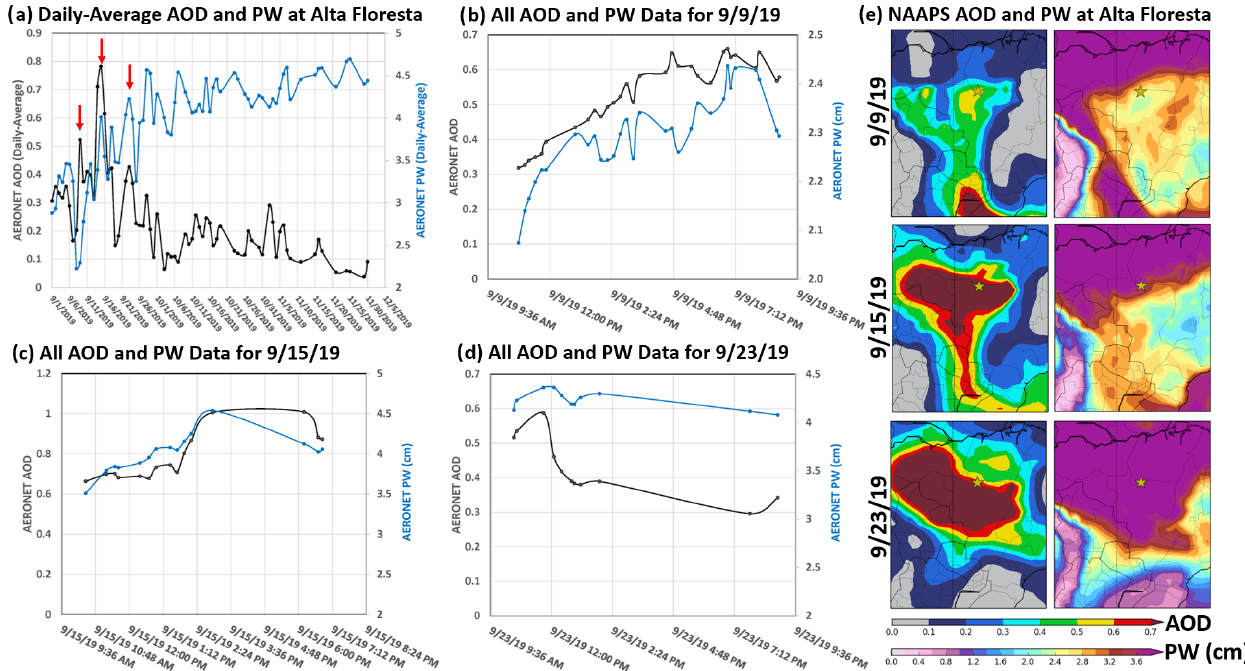
Figure 18. AOD and PW time series at the Alta Floresta site in Brazil in which negative AOD and PW correlations were identified in the seasonal analysis. The daily-average AOD and PW time series are shown for the 2019 SON season, with red arrows indicating select events for further evaluation (a) . AERONET AOD and PW time series (non-averaged, all data) for the selected events are shown in time series (b–d) . Additionally, NAAPS-RA AOD and PW (cm) fields are shown for the same dates, with the AERONET site marked with a yellow star (e)